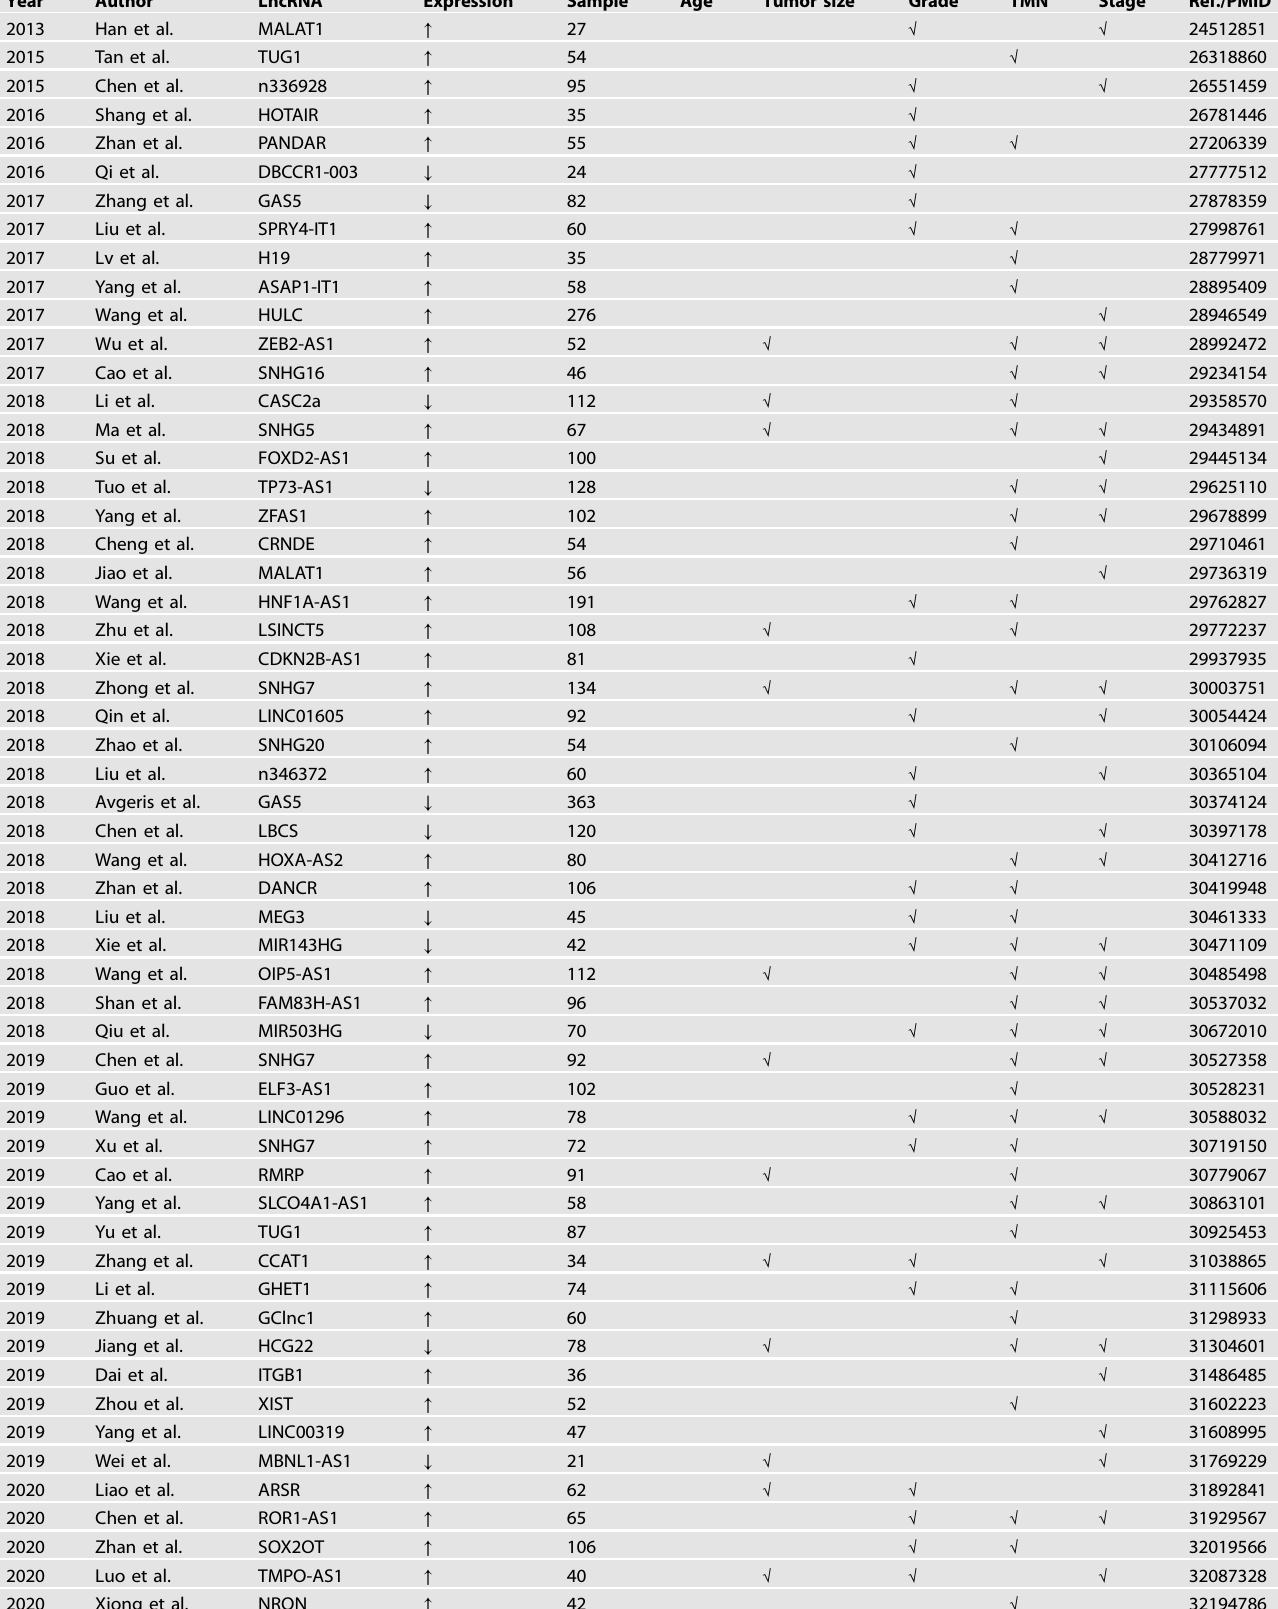
Table 2. Relationship between LncRNAs level and clinicopathologic characteristics in